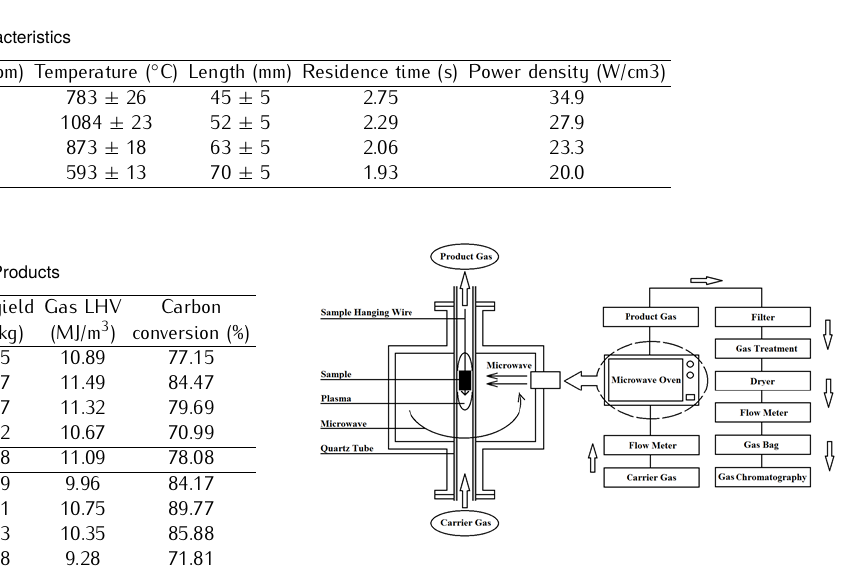
Figure 1. The experimental setup of the microwave plasma reactor for the pyrolysis of the RDF.